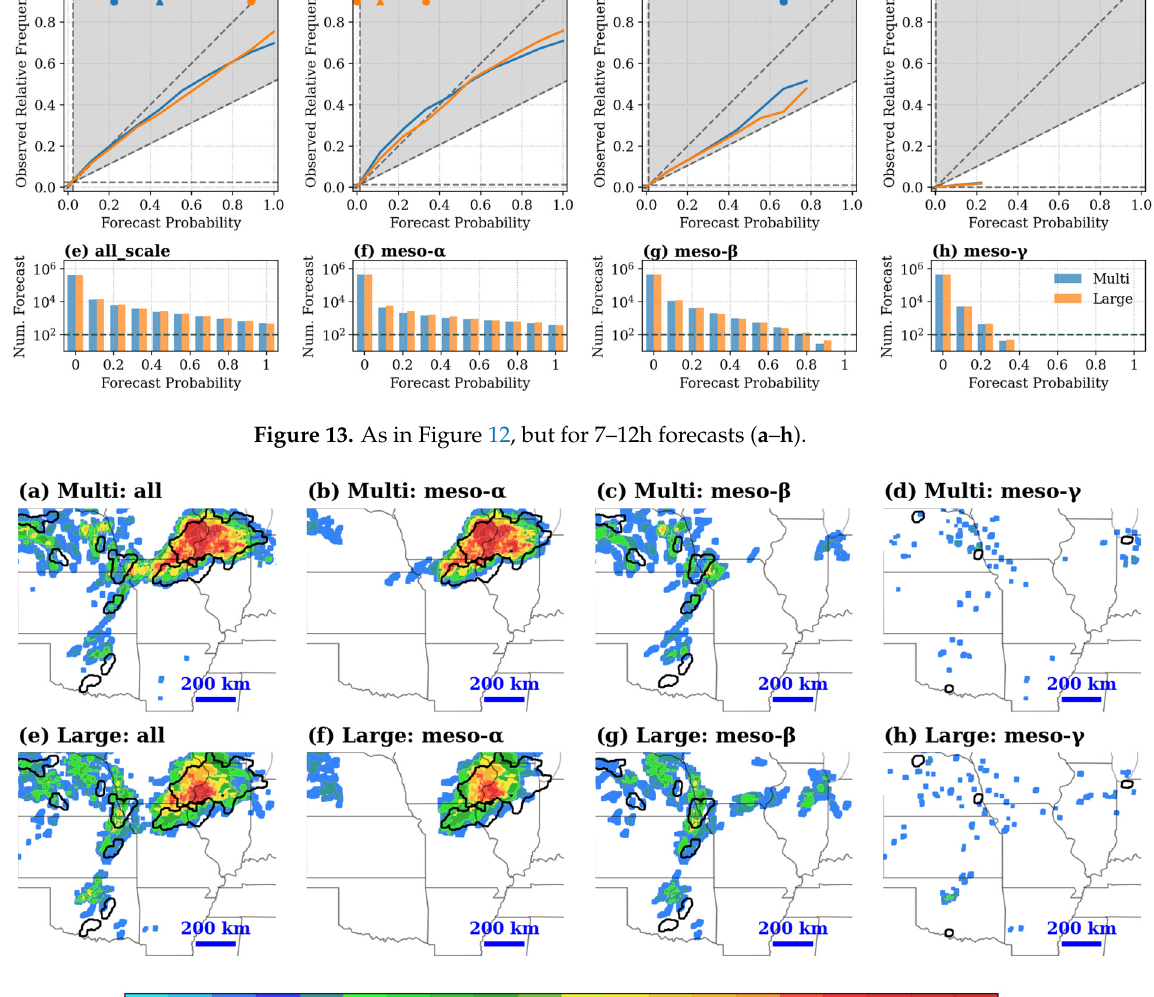
Figure 14. NMEPs with 35 dBZ thresholds and neighborhood sizes of 9 km for the full field ( a , e ), meso-alpha ( b , f ), meso-beta ( c , g ), and meso-gamma ( d , h ) subfields of MULTI and LARGE for 27h forecasts valid at 03z, 29 May 2019. The black contours in each subfigure mark areas of MRMS reflectivity greater than 35 dBZ for the respectively full field (in a , d ) and scale-dependent subfields (in b – d , f – h